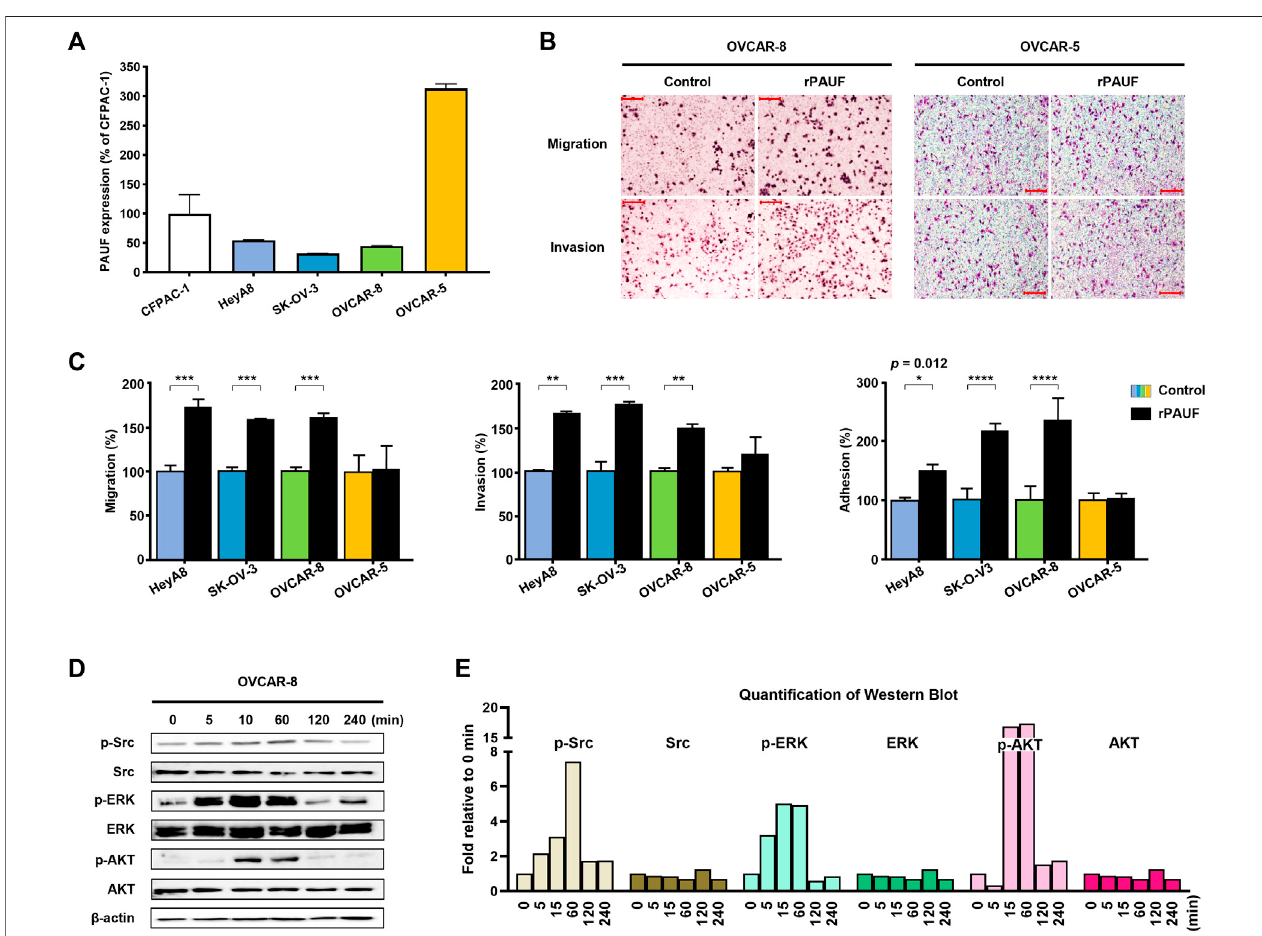
FIGURE 1 | Enhancement of PAUF expression promoted cancer metastatic capacity in a baseline PAUF dependent manner. (A) Expression level of PAUF in ovarian cancer cells relative to pancreatic cancer cell CFPAC-1 was determined by Sandwich ELISA. (B) Effects of recombinant PAUF (rPAUF, 0.5 μ g/ml) and PBS controlonmetastaticcapacity(migration,invasion,andadhesion)ofovariancancercells. (C) Microscopyimages(at×100magni fi cation)ofmigrationandinvasionassay results in OVCAR-8 and OVCAR-5 ovarian cancer cells. Scale bar: 100 μ m. (D) Western blot images and (E) image quanti fi cation showed time-dependent effects of rPAUF treatment (0.1 μ g/ml) on Src, ERK, and AKT expression in OVCAR-8 cell be-tween 0 and 240 min. The original images of blots are shown in Supplementary Figure S1 . p p < 0.05, pp p < 0.01, ppp p < 0.001, pppp p < 0.0001.